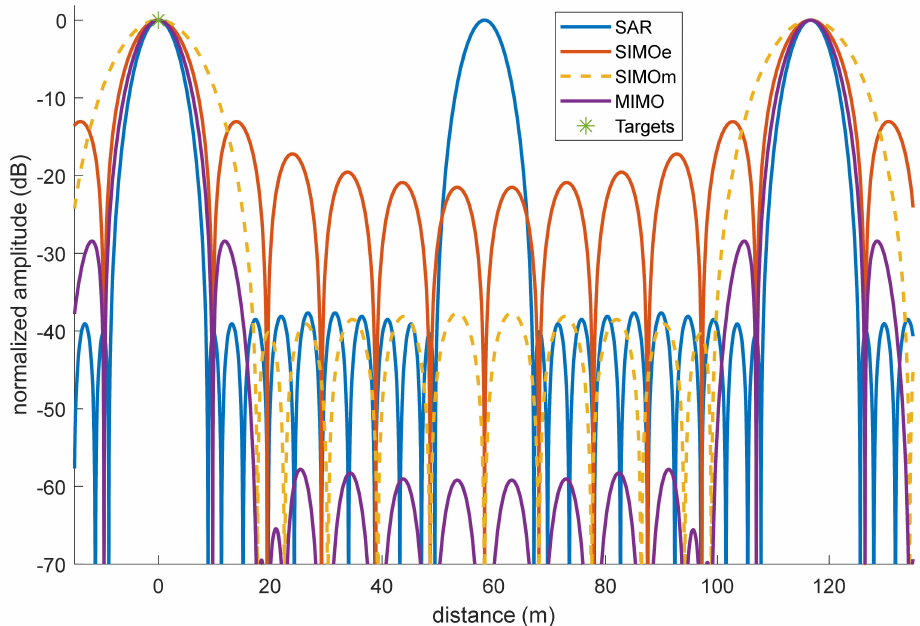
Figure 16. Tomographic “images” in 1D for the SAR, SIMO, and MIMO modes. Green asterisk shows the position and intensity of the point target at origin. A Taylor window of − 60 dB sidelobe level is